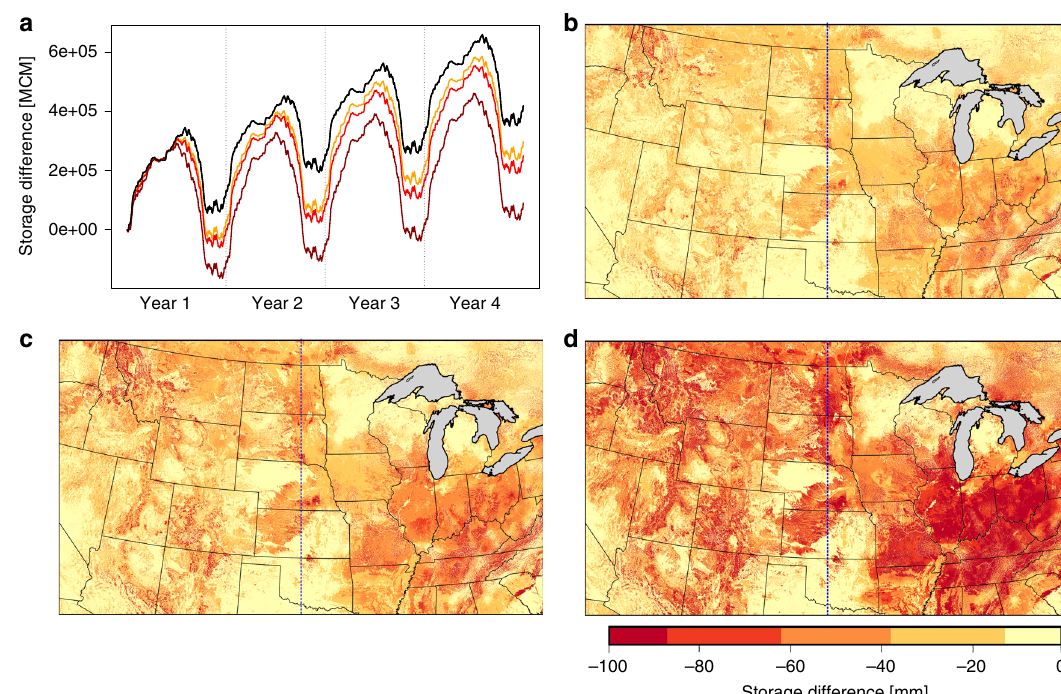
Fig. 4 Warming results in groundwater storage losses. a Timeseries of the daily total storage relative to the initial storage (baseline in black, 1.5° in orange, 2 °C in red, and 4 °C in dark red). Maps of the ending storage difference between each of the warming scenarios; 1.5 °C ( b ), 2 °C ( c ), and 4 °C ( d ) relative to the Baseline ending storage. The dashed blue line is the center of the domain dividing east and